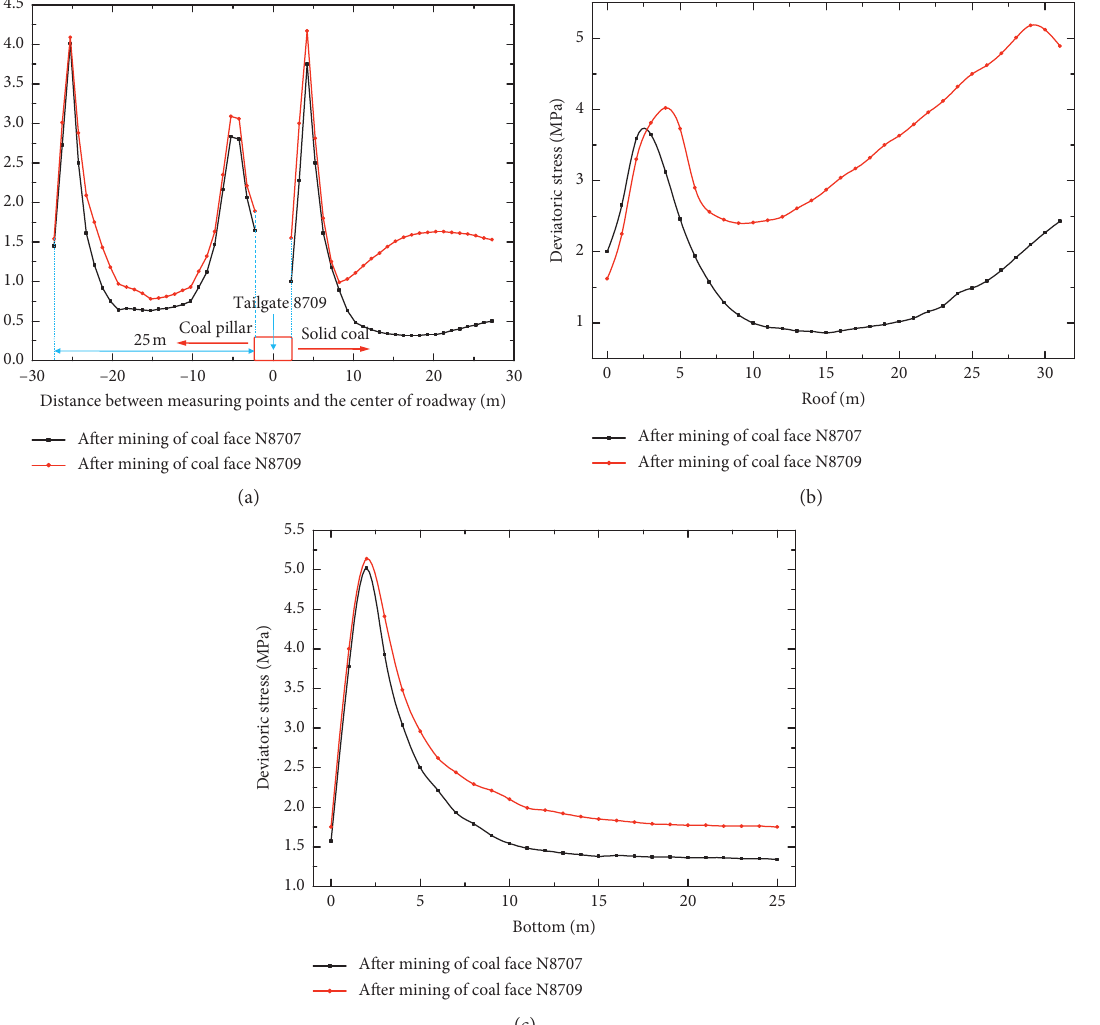
Figure 5: Deviatoric stress curves after mining of N8707 and N8709 coal faces in No. 7-4 coal seam: (a) deviatoric stress curves in coal pillar and solid-coal side; (b) deviatoric stress curves of the roof; (c) deviatoric stress curves of the bottom.